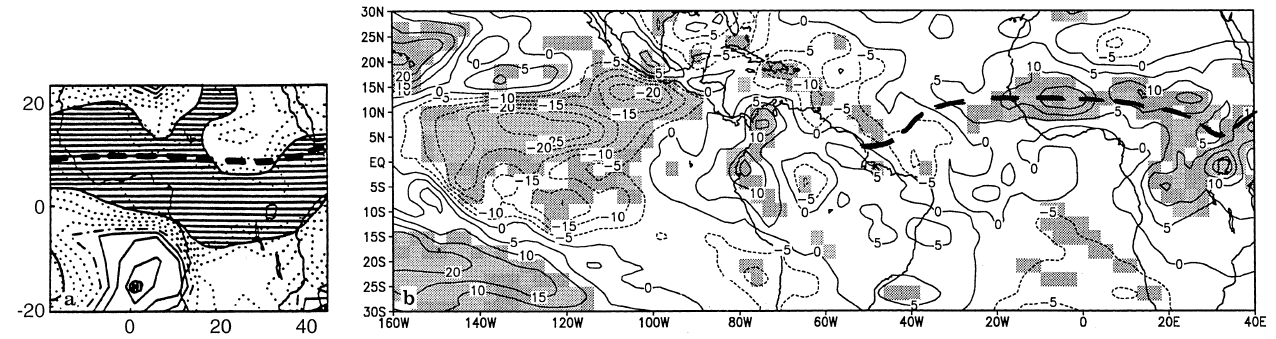
1993). b Simulated OLR anomalies for the ‘‘ENSO’’ run relative to the control run. Isolines every 5 Wm (cid:41) 2 ; positive values ( full lines ) indicate weakened convection. The heavy dashed line indicates the location of the simulated climatological minima of OLR. Anomaly areas significant at the 5% (1%) level are shaded in dark ( light )